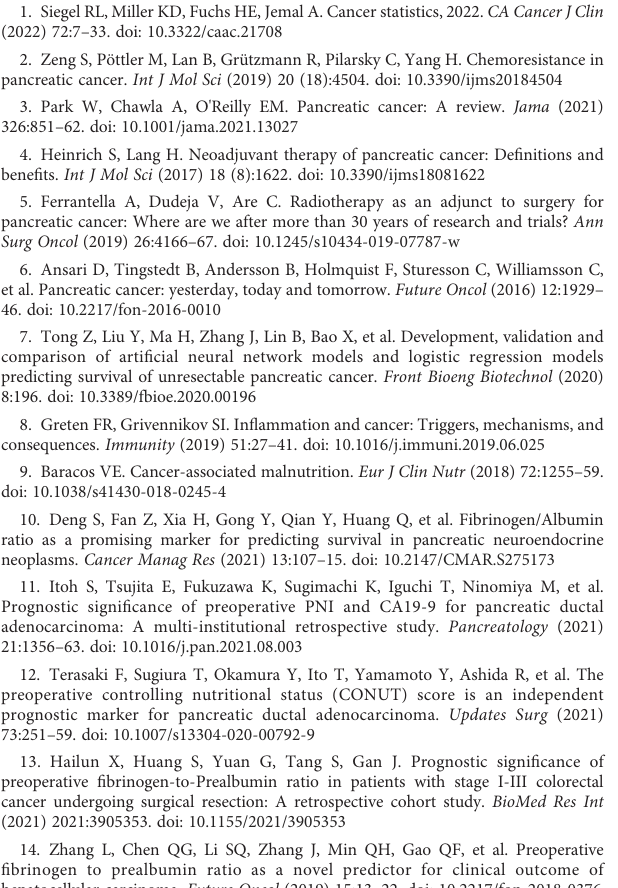
SUPPLEMENTARY FIGURE 1 Kaplan – Meier curves of overall survival in patients with resectable pancreatic cancer strati fi ed by fi brinogen-to-prealbumin ratio (A), fi brinogen-to- albumin ratio (B), neutrophil-to-lymphocyte ratio (C), prognostic nutritional index (D), controlling nutritional status (E); SUPPLEMENTARY FIGURE 2 Time-dependent AUC plot for survival prediction of immune- nutritional